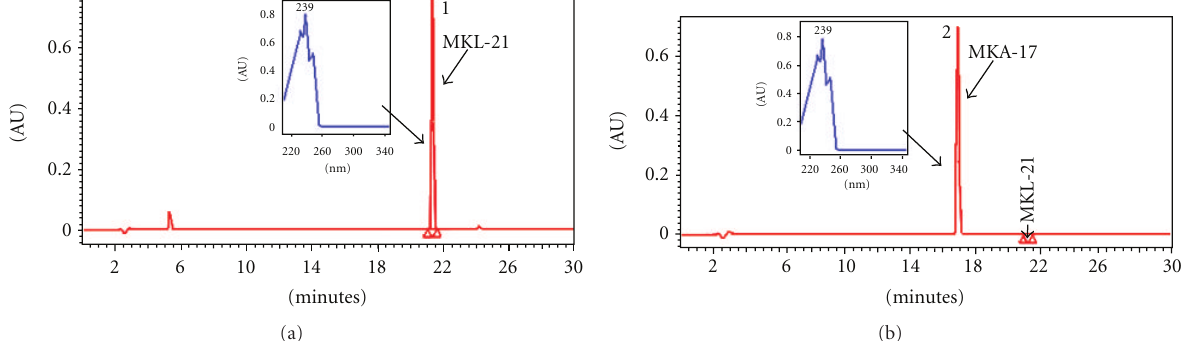
Figure 1: HPLC chromatogram profile with UV spectra of monacolin K standard. (a) Monacolin K lactone form (MKL) chromatogram, and (b) monacolin K acid form (MKA) chromatogram.